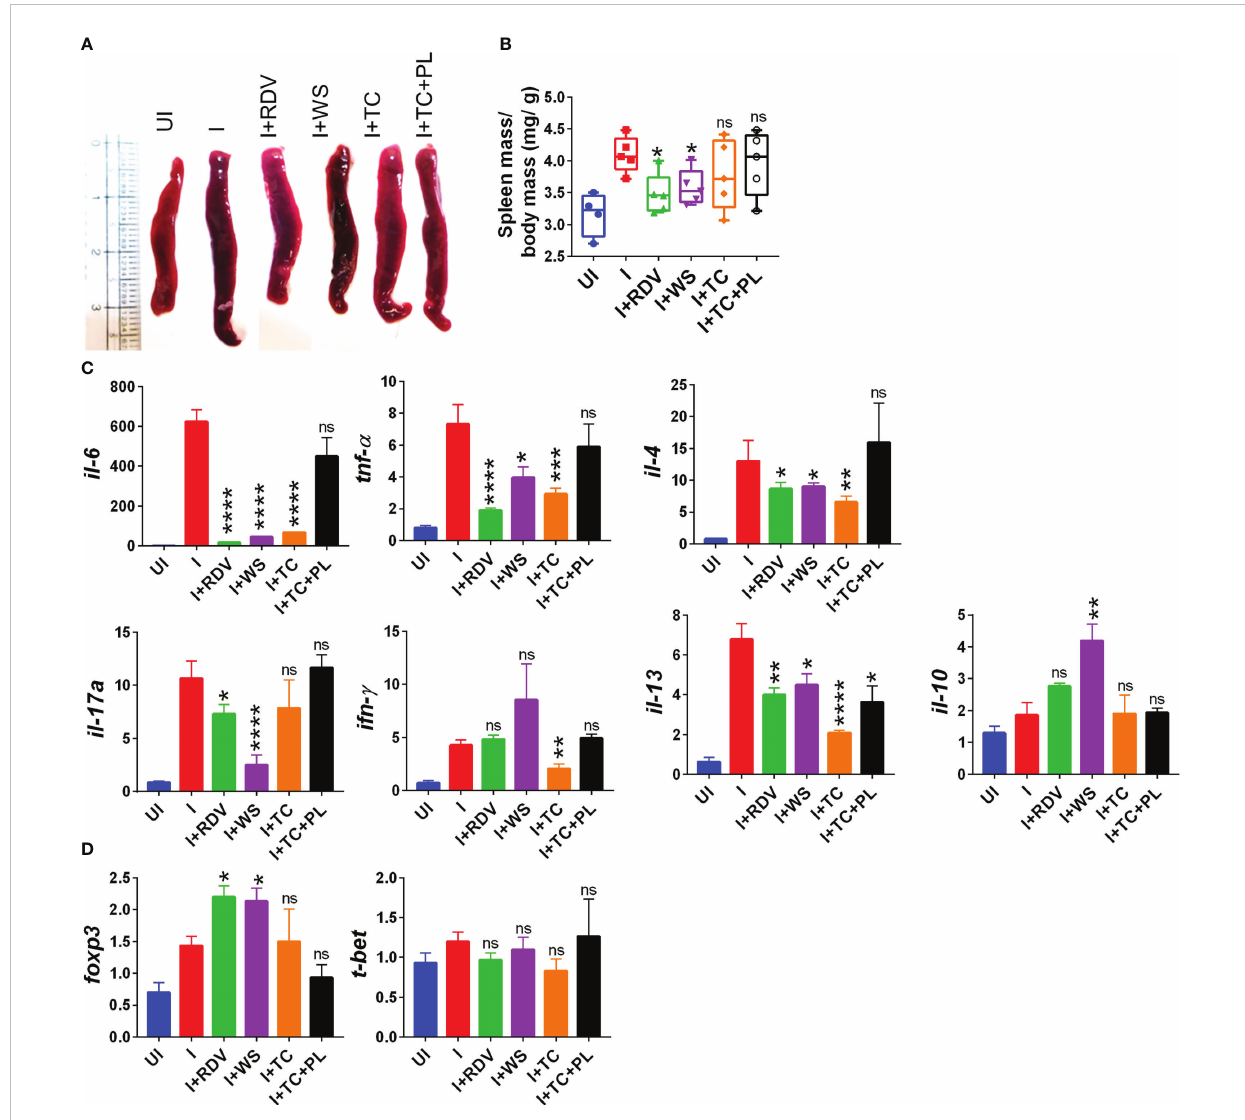
FIGURE 2 Immunomodulatory effects of WS or TC on the infected hamsters. Immunomodulatory activity of prophylactic treatment of WS or TC on infected vs uninfected hamsters were studied. (A) representative spleen images harvested post necropsy. (B) changes in spleen mass to body mass ratio for different groups (C) modulation in the mRNA expression of pro-in fl ammatory cytokines and (D) transcription factors. For each experiment N=5. One way-Anova using non-parametric Kruskal-Wallis test for multiple comparisons. *P < 0.05, **P < 0.01, ***P < 0.001, ****P <